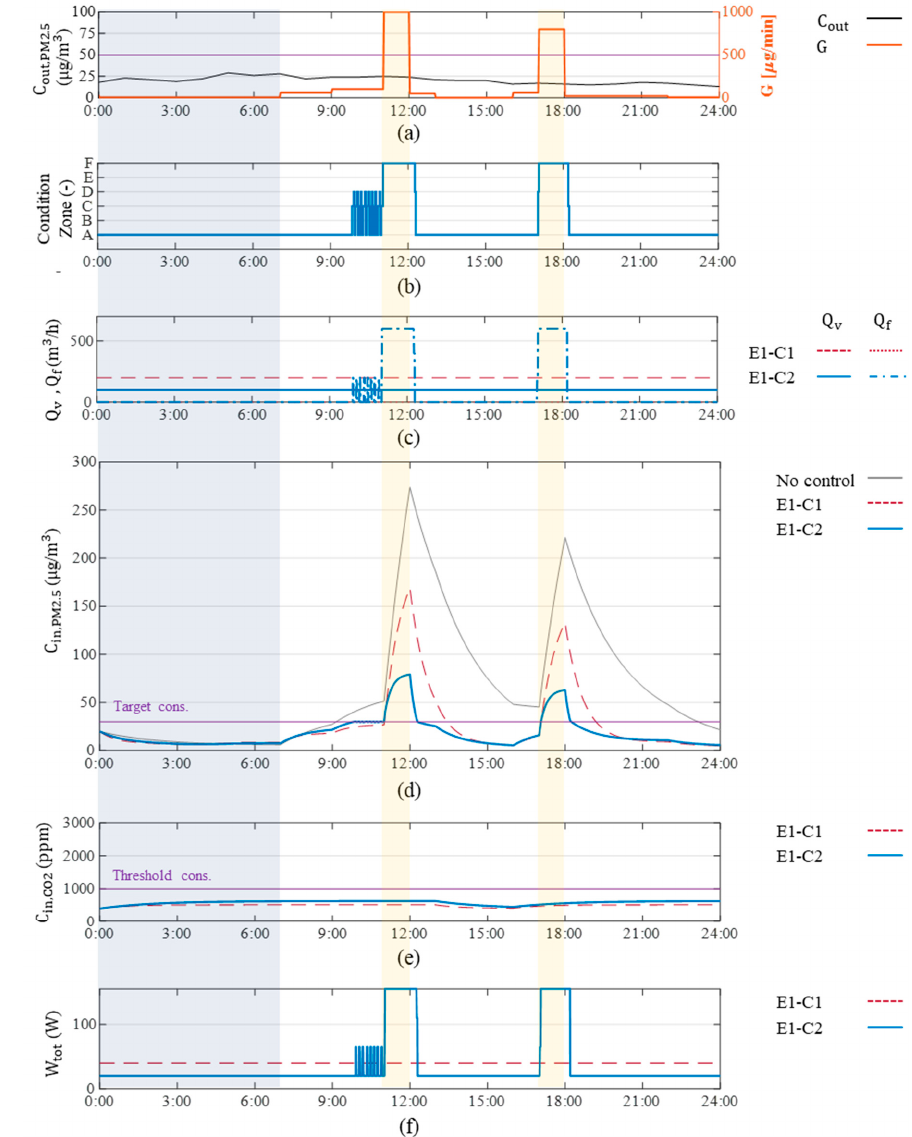
Figure 15. The results of ( a ) indoor and outdoor PM conditions, ( b ) condition zones, ( c ) operation flow rates of the system, ( d ) indoor PM2.5 concentration, ( e ) indoor CO 2 concentration, and ( f ) system fan power consumption during E1.